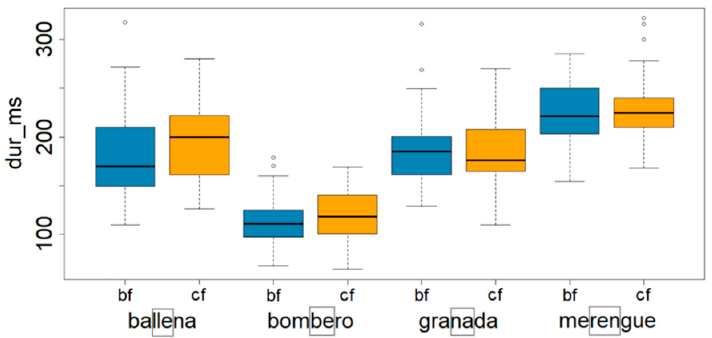
Figure 6. Duration (in ms) of the stressed syllables of the target words in object position in broad focus (“bf”) and contrastive focus (“cf”) conditions.